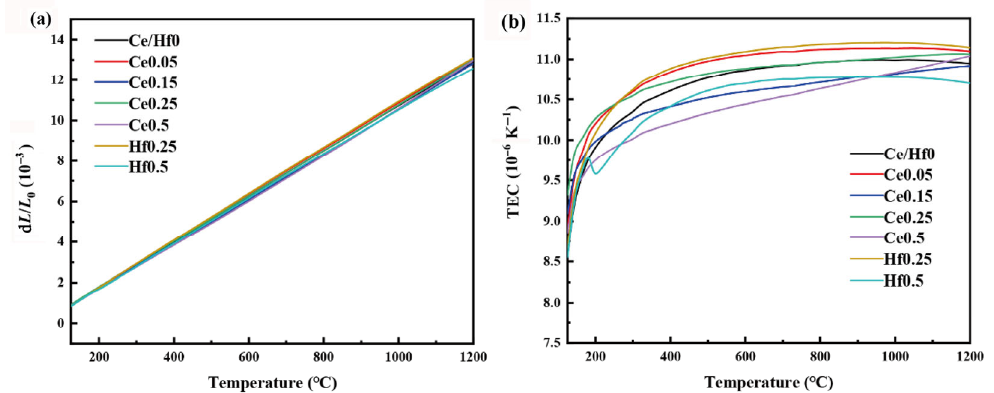
(Table 3), and 8YSZ: 10.7×10 − 6 K − 1 [37],